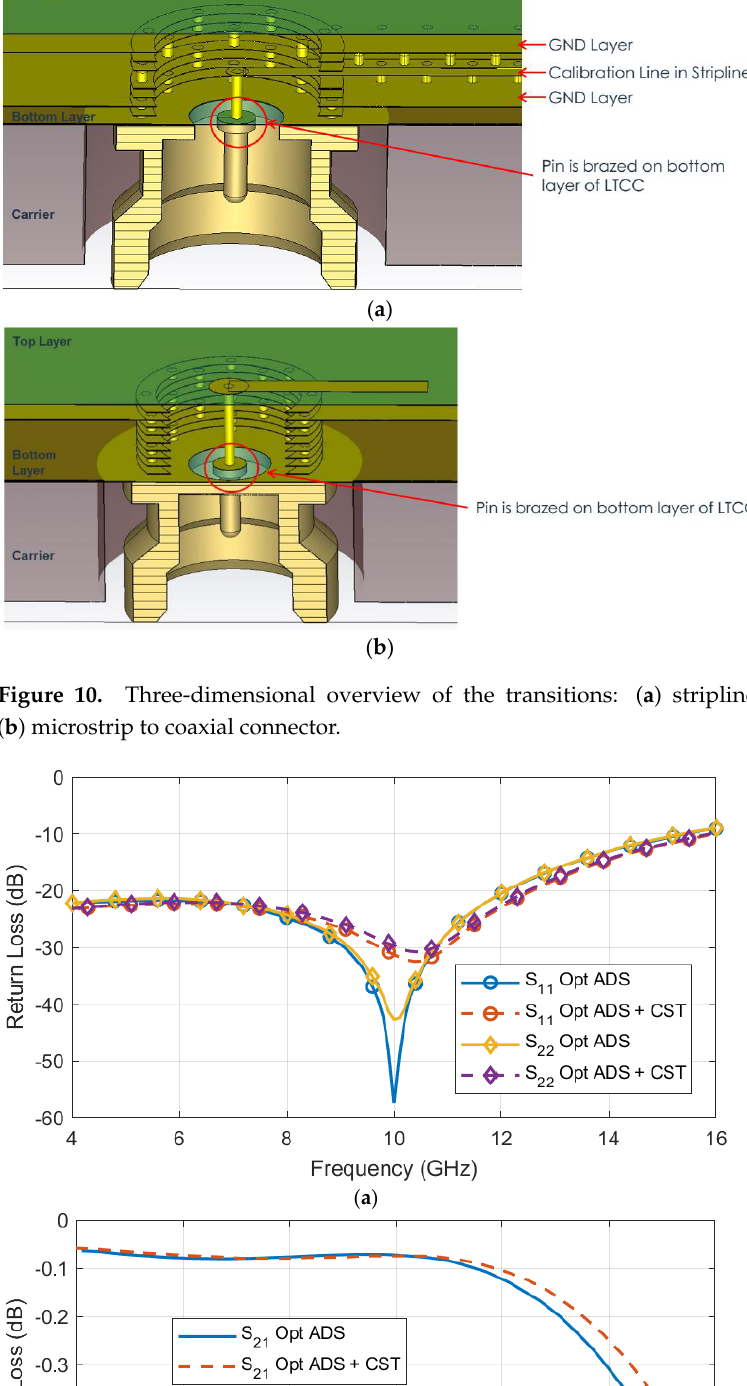
11 and S 22 , ( b ) S 21